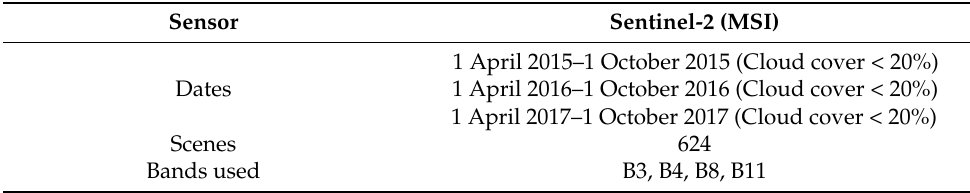
Table 2. Sentinel-2 Multispectral Instrument (MSI) image